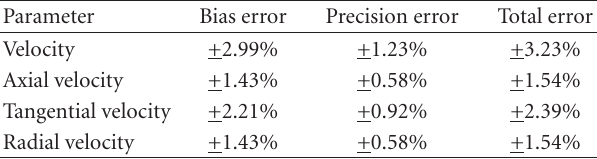
Table 4: Uncertainty in hot wire probe measurements.